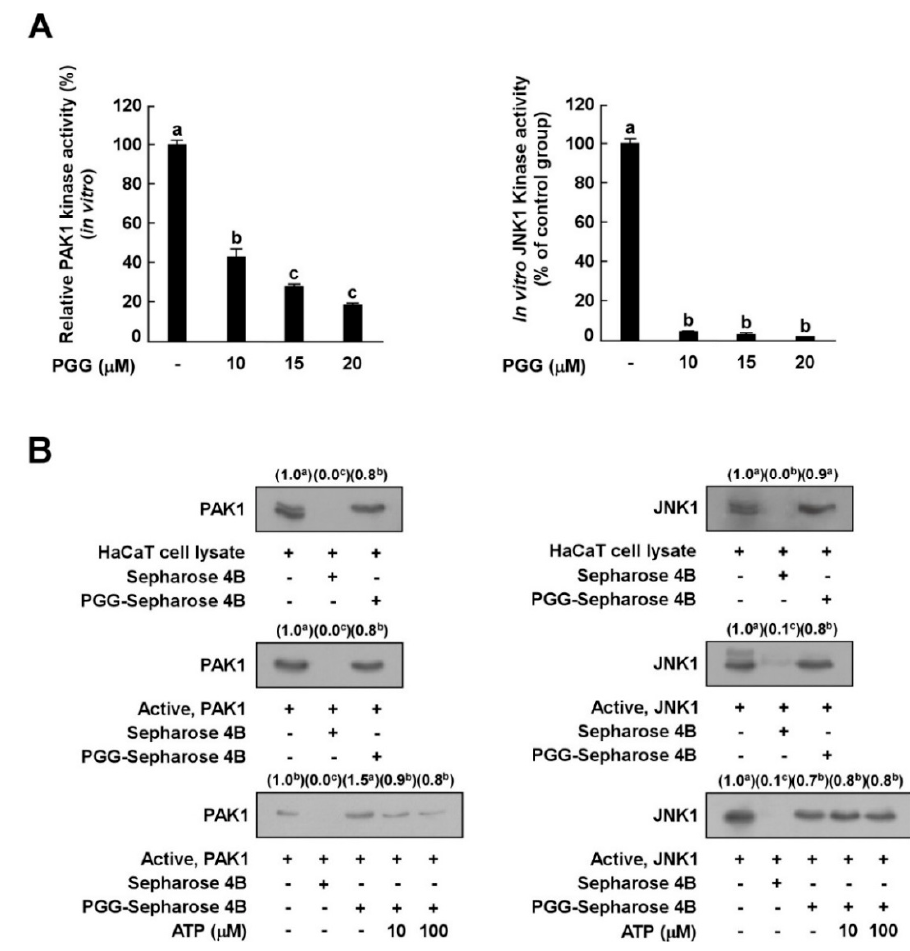
Figure 4. Effect of PGG on PAK1 and JNK1 kinase activities. ( A ) Kinase activities are expressed as the percentage of relative inhibition to untreated control PAK1 or JNK1 activities. Data are presented as the mean ± S.D., as determined from three independent experiments. ( B ) Binding of PGG with PAK1 or JNK1. Western blot analysis using antibodies against PAK1 or JNK1 was executed to confirme the PAK1- or JNK1-PGG binding in vitro ( B , upper panels); first lane (input control), PAK1 or JNK1 protein standard; second lane (negative control), PAK1 and JNK1 with Sepharose 4B; third lane, PAK1 and JNK1 with PGG-Sepharose 4B beads. Middle panels; first lane (input control), whole cell lysate from HaCaT cells; second land (negative control), lysate from HaCaT cells precipitated with Sepharose 4B beads; third lane, whole cell lysate from HaCaT cells precipitated with PGG-Sepharose 4B affinity beads. Lower panels; first lane (input control), active PAK1 or JNK1; second lane (negative control), PAK1 and JNK1 with Sepharose 4B beads; third lane (positive control), PAK1 and JNK1 with PGG-Sepharose 4B beads; fourth and fifth lanes, increasing concentrations of ATP suppress the binding of PGG to PAK1, but not JNK1. Data are representative of three independent experiments that yielded similar results. The values in parentheses represent the means of the relative intensity to the input control (first lane), and values that do not share common letter (a,b,c) on bar indicate statistically significant difference from each other ( p < 0.05).